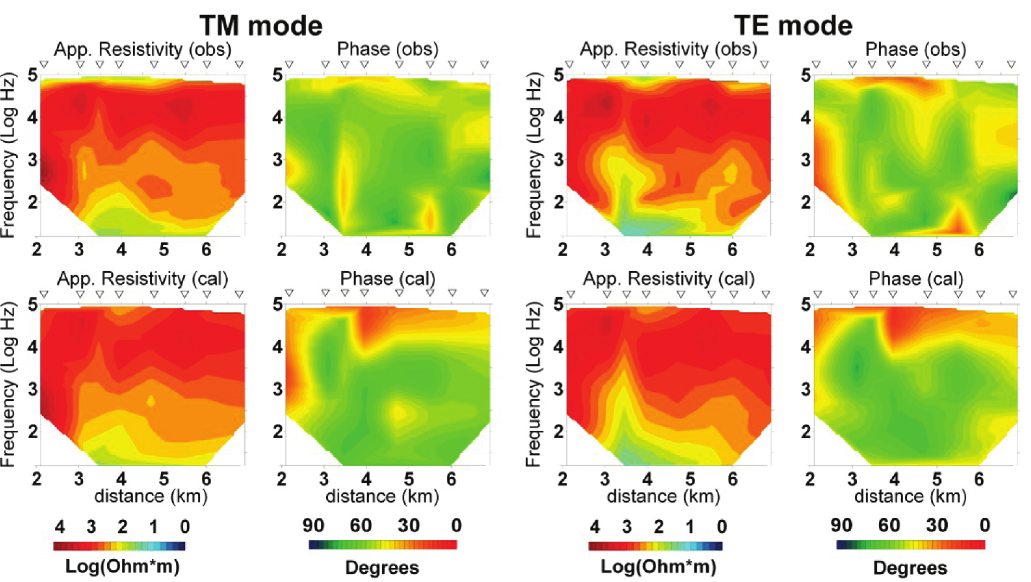
Fig. 8. Pseudosection for the CSAMT profile and response of the best fit model shown in fig. 7. Data are fit- ted with an rms of 3.3.